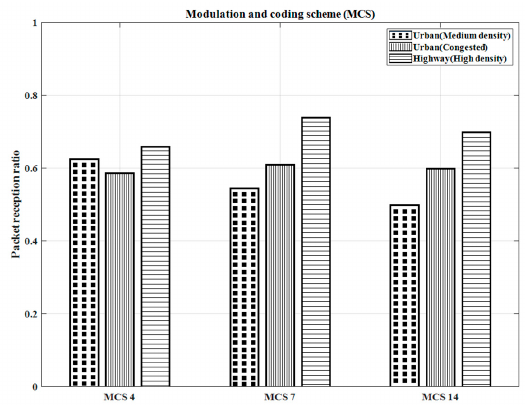
Figure 8. Impact of variations in modulation and coding schemes (MCS) on the packet reception ratio.